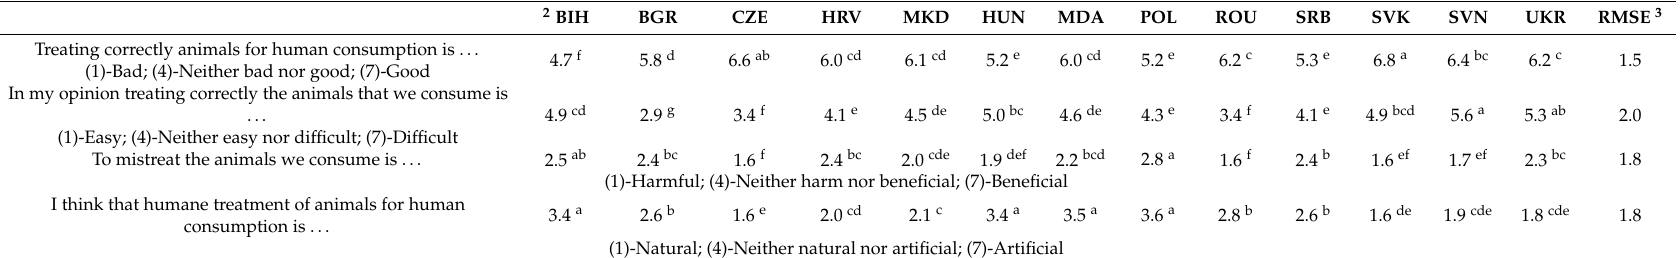
2 BIH BGR CZE HRV MKD HUN MDA POL ROU